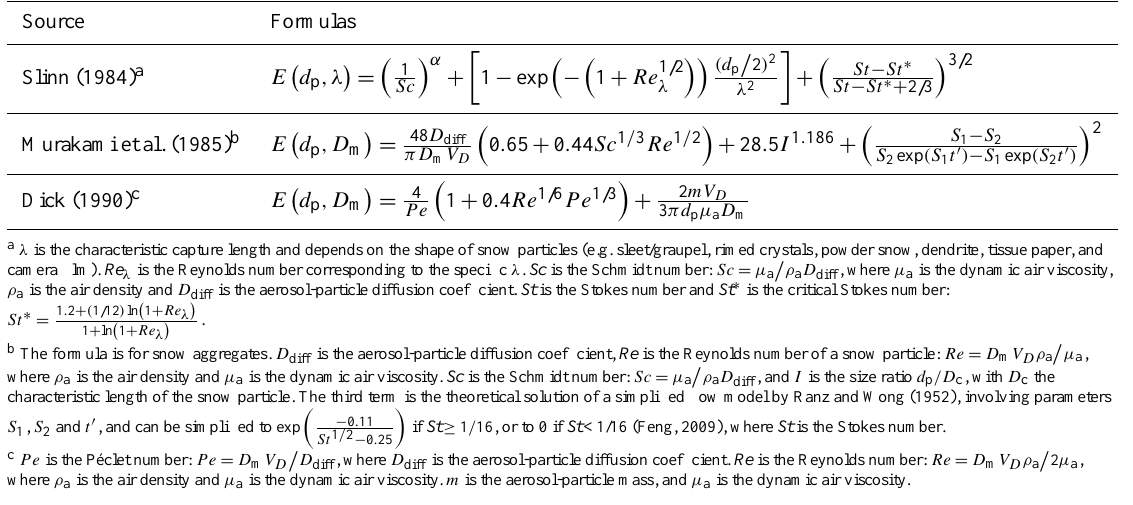
Table 1. List of semi-empirical formulas for E(d p , D p )